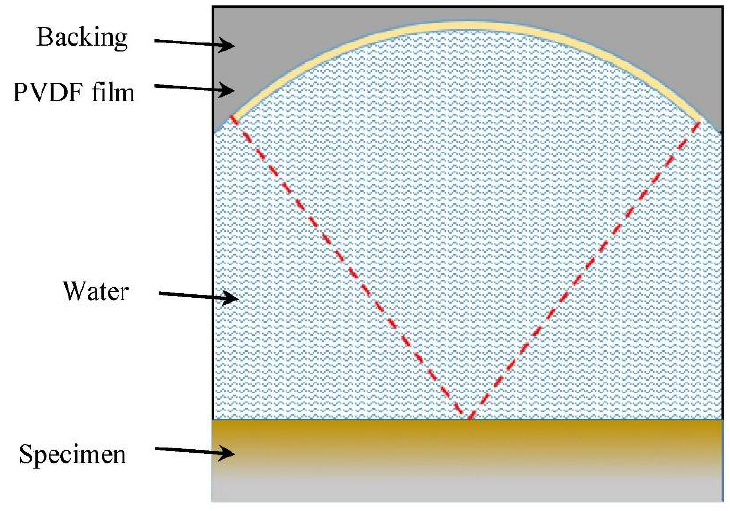
Figure 8. Finite element simulation model.